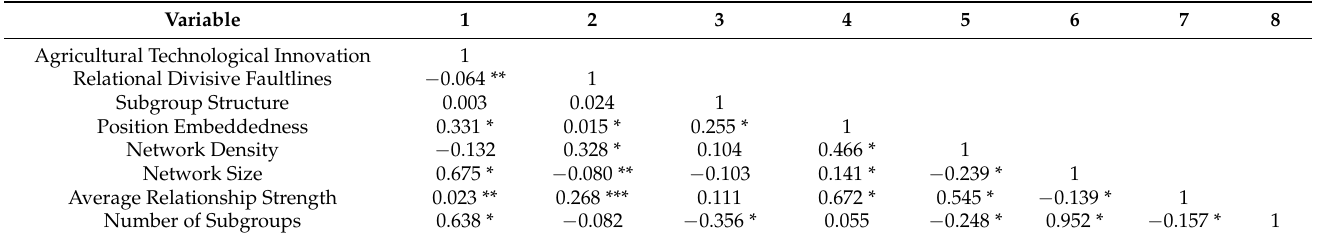
Table 3. Correlation Table of Measured